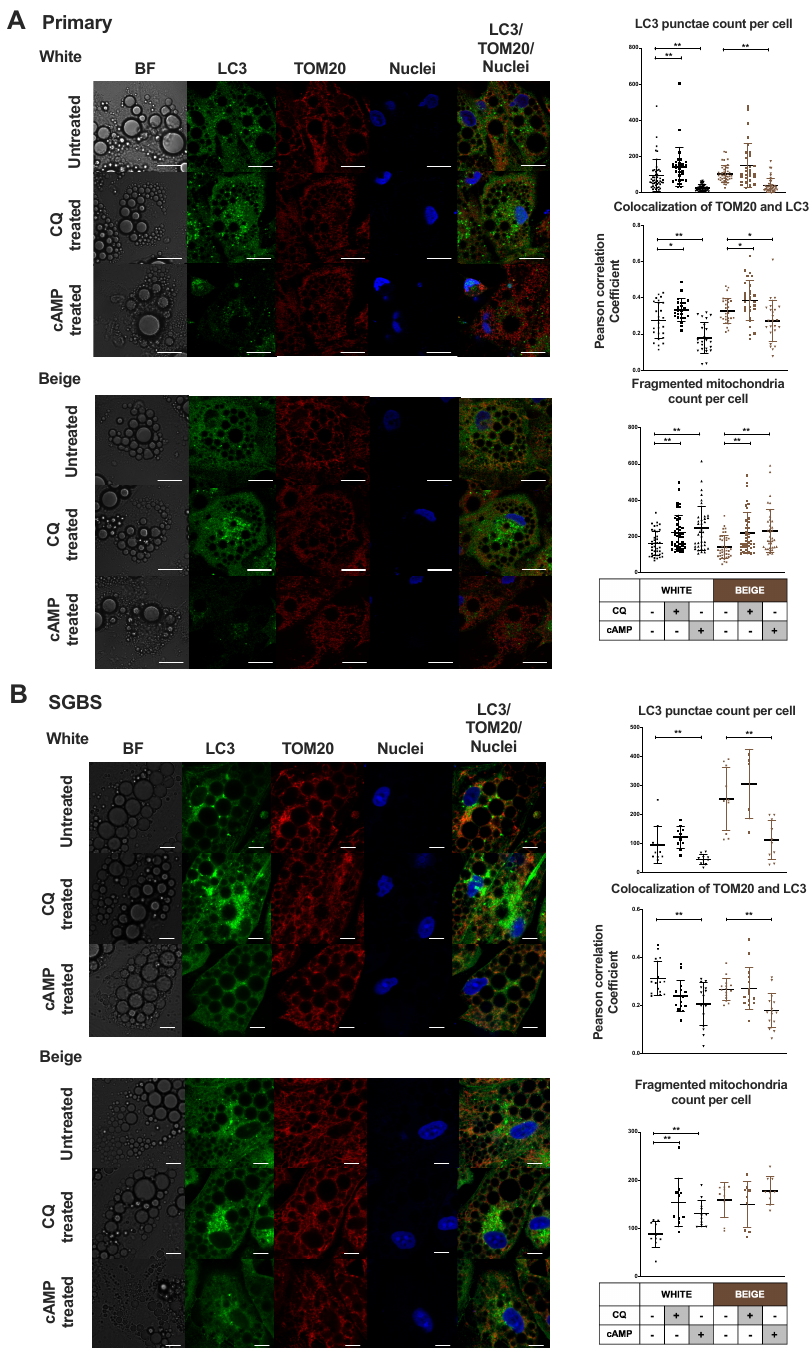
Figure 3. Confocal microscopy images show decreased LC3 punctae, co-localization of LC3 Translocase of outer mitochondrial membrane (TOM) 20 and increased mitochondrial fragmentation in cAMP-stimulated adipocytes. Adipocytes were di ff erentiated as in Figures 1 and 2. Representative confocal microscopy images of LC3 and TOM20 immunostaining (left) under untreated conditions and upon CQ (25 µ M, 1 h) and cAMP (500 µ M, 8 h) treatment in white and beige ( A ) primary and ( B ) SGBS cells. Scale bars represent 5 µ m ( A ) or 10 µ m ( B ). Quantification of LC3 punctae, co-localization of LC3-TOM20 and fragmented mitochondria (right) from confocal images ( A ) in hASC-derived ( n = 40–60 cells, from 3 donors) and ( B ) SGBS cells ( n = 10–15 cells). Nuclei were stained by propidium-iodide. Results are expressed as mean ± SD. Statistics: Mann–Whitney U test; * p < 0.05; ** p <